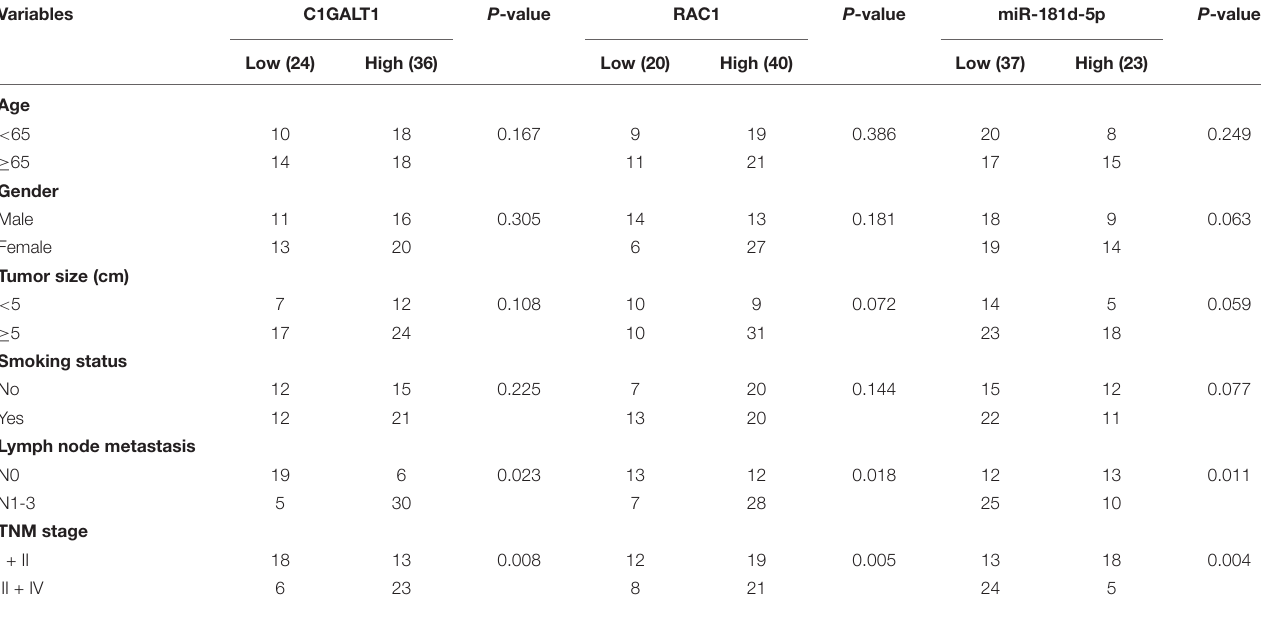
TABLE 2 | Relevance analysis of C1GALT1, RAC1, and miR-181d-5p expression in LUAD